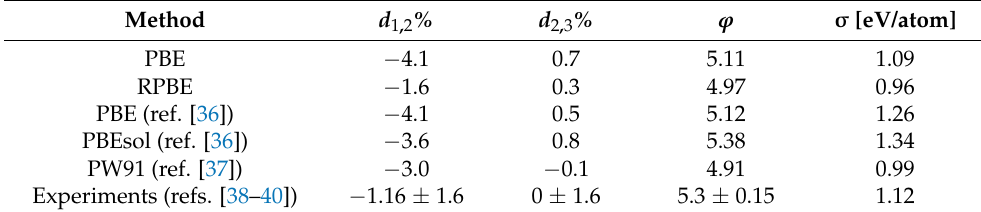
Table 1. Surface relaxations d 1,2 % and d 2,3 %, work function ϕ and surface energies σ for the Rh (100) slab, relaxed with PBE and RPBE functionals, together with available theoretical and experimental literature